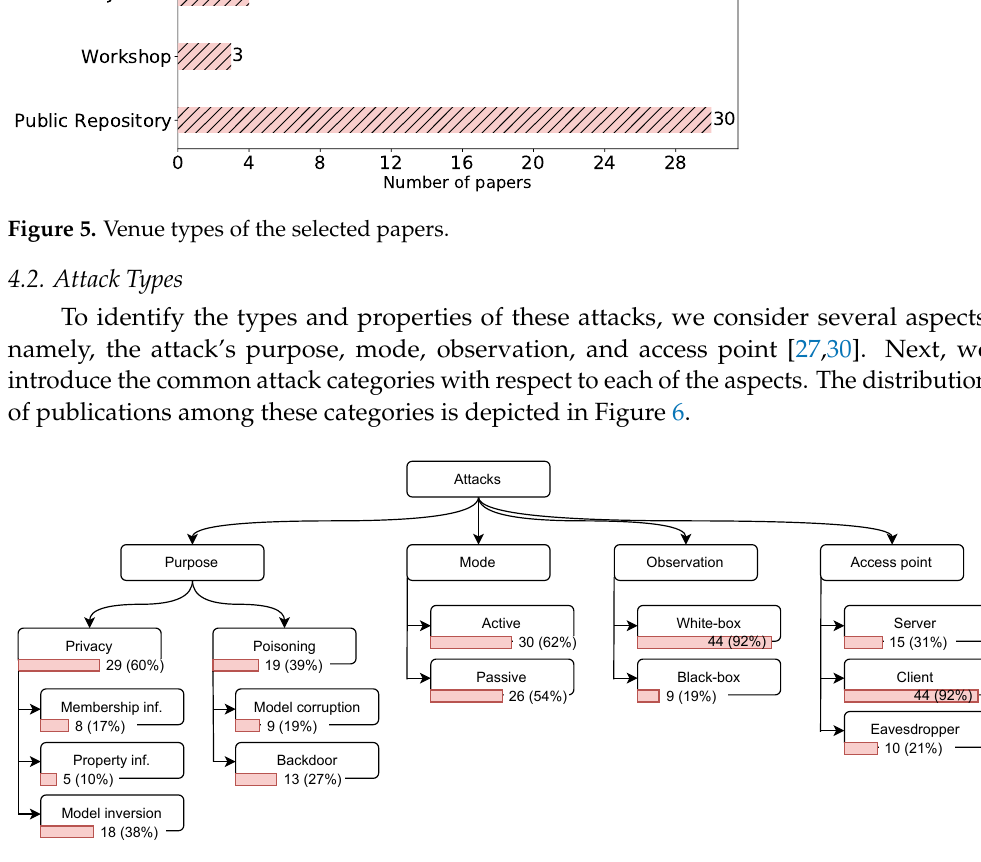
Figure 6. Attack classification with the papers’ distribution. The percentage is with regard to the total number of papers, 48. Most categories are not exclusive; therefore, the papers might sum up to more than 48. More details on the individual papers can be found in Table